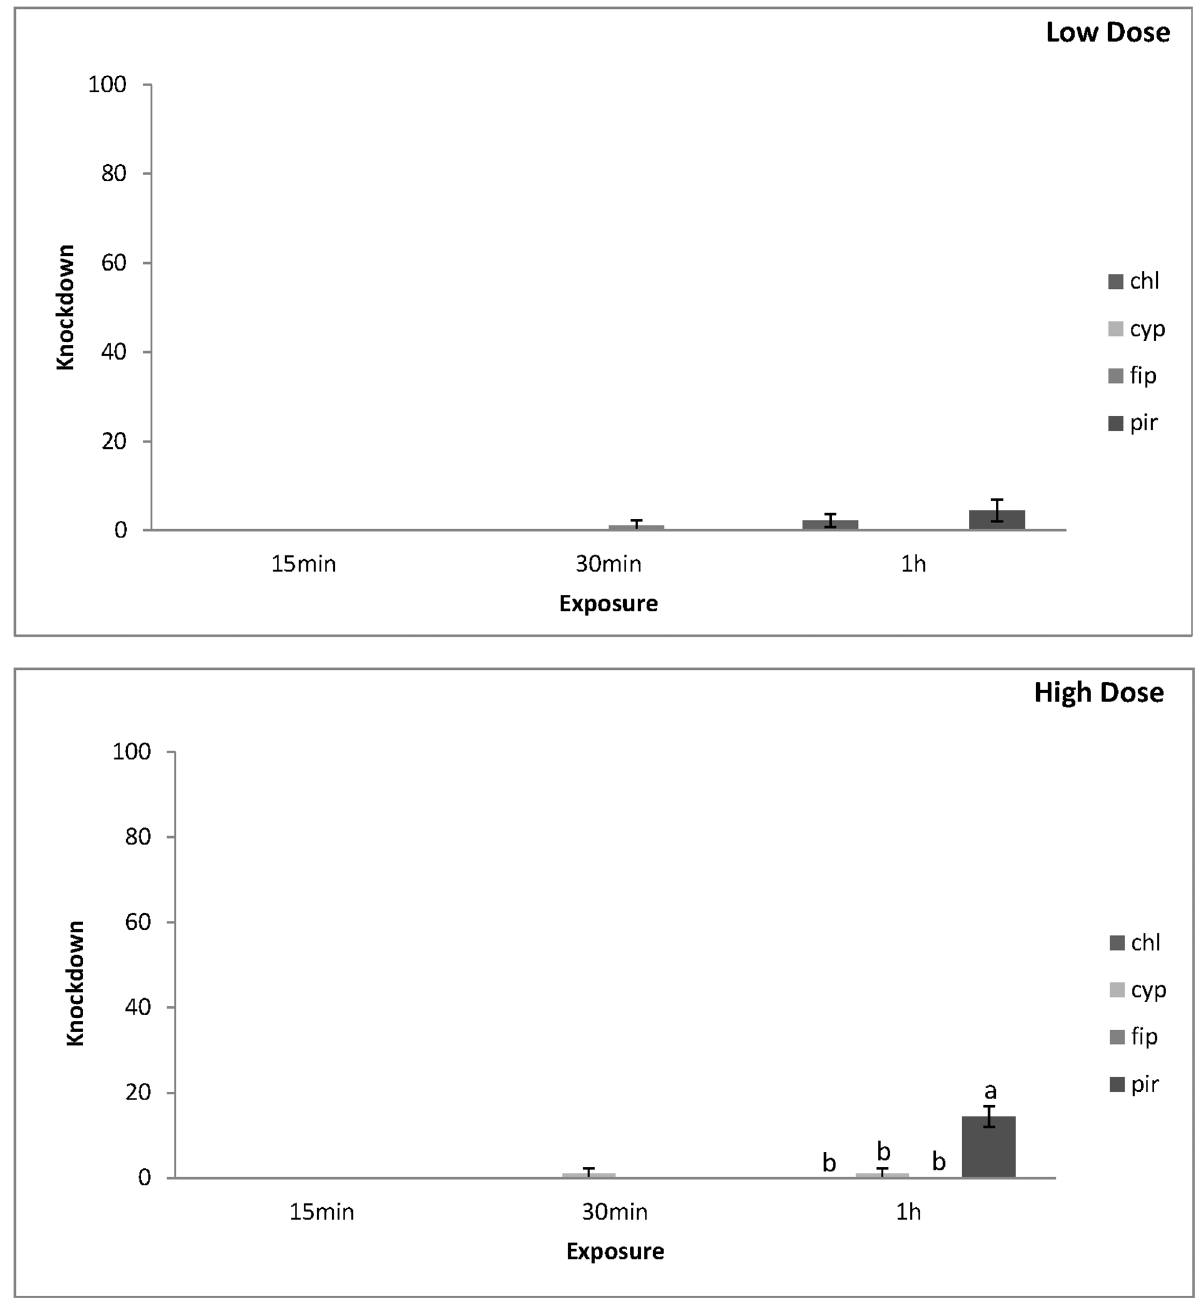
Fig 1. Mean Knockdown of T . confusum adults on concrete surfaces at low and high dose. Mean Knockdown (% ± SE) of T . confusum adults on concrete treated with chlorfenapyr (chl), alpha-cypermethrin (cyp), fipronil (fip) and pirimiphos-methyl (pir), at the low and the high dose rate of each insecticide after 15 min, 30 min and 1 h exposure intervals.